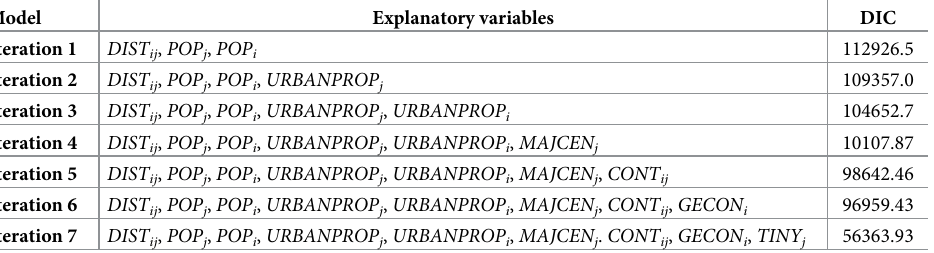
Table 2. Iterative model selection based on Deviance Information Criterion (DIC) using forward step-wise inclu- sion for fine-scale models, with a single variable added at each